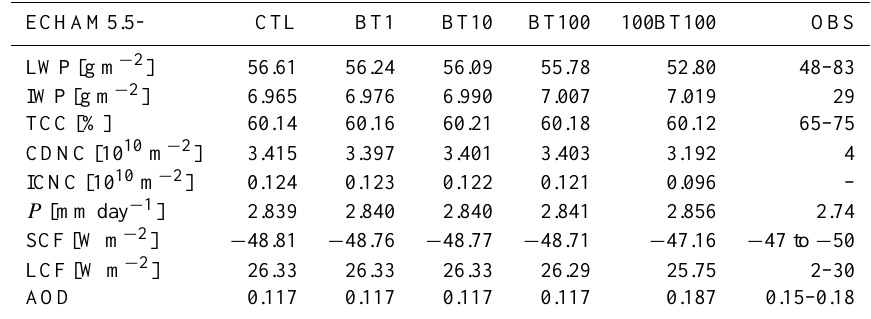
Table 6. Yearly average values for the simulations CTL, BT1, BT10 and BT100 compared to observations (OBS). The table displays liquid water path (LWP), ice water path (IWP), total cloud cover (TCC), the vertically integrated cloud droplet number concentration (CDNC) and ice crystal number concentration (ICNC), total precipitation ( P ), shortwave cloud forcing (SCF), longwave cloud forcing (LCF), radiation budget at the top of the atmosphere F net and aerosol optical depth (AOD). See Table 1 for the description of the simulation acronyms. Global averaged annual estimates and zonal mean estimated observational data are taken from the Global Precipitation Climatology Project (GPCP) for total precipitation P tot (Huffman et al., 1997; Adler et al., 2003). LWP stem from satellite (SSM/I) retrievals by Wentz (1997), Greenwald et al. (1993) and Weng and Grody (1994). IWP is derived from the International Satellite Cloud Climatology Project ISCCP data (Storelvmo et al., 2008). Cloud droplet number concentration N l retrievals from Han et al. (1998) is available for 50 ◦ N to 50 ◦ S. Shortwave and longwave cloud forcing (SCF and LCF) are deduced from Kiehl and Trenberth (1997). The data of aerosol optical depth AOD are provided by Schulz et al. (2006) and S. Kinne (personal communication, 2008). Cloud cover observations are derived from observations of ISCCP (Rossow and Schiffer, 1999), surface observations collected by Hahn et al. (1995) and satellite observations estimated by Stubenrauch and Kinne